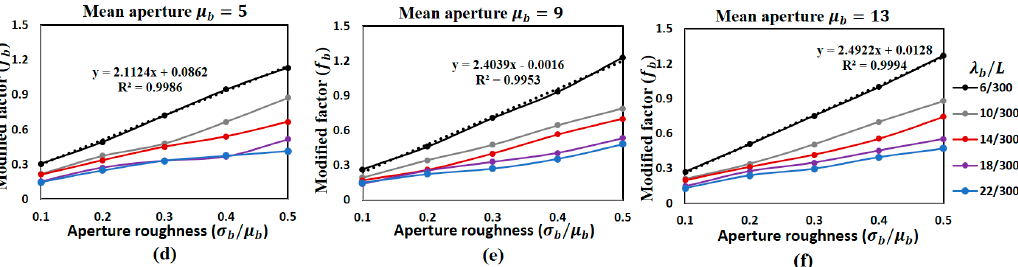
Figure 11. Relationships between the modified factor ( f b ) and aperture correlation length ( λ b ) of (a–c) and fracture wall roughness ( σ b / μ b ) of (d–f) for three groups of fracture models with the respective mean apertures of 5, 9, and 13 (in voxels), in which two trend surface parameters are set as to σ T2 = 0, λ T = ∞ . Where L presents the fracture size in X or Y direction, and the black dotted lines are the fitted curves for three corresponding black solid lines for fracture models of σ b / μ b = 0.5 or λ b /L = 6/300.